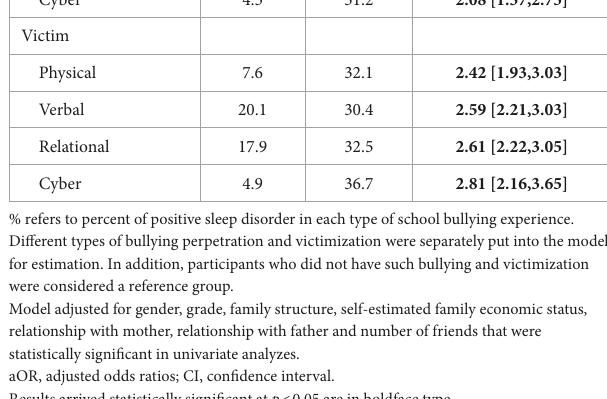
TABLE 3 Multivariate logistic regression of adolescent sleep disorder on number of school bullying types ( N = 5,724). Variety of school bullying